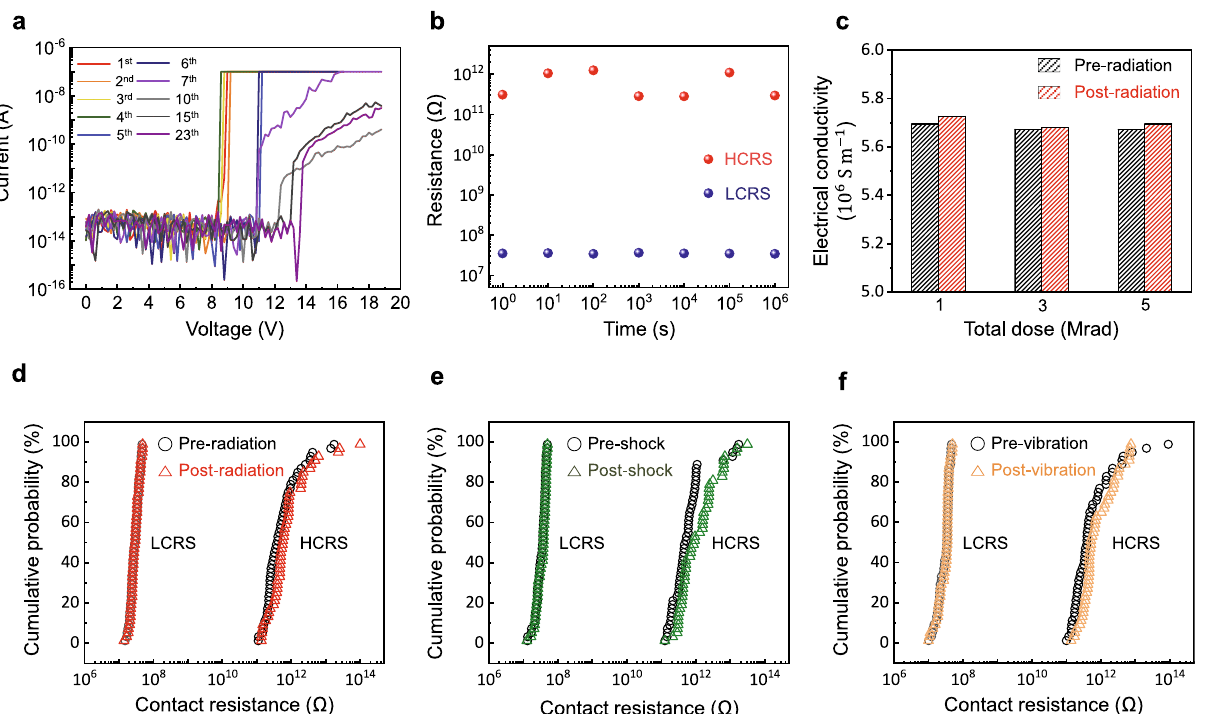
Fig. 4 | Basic NEM-NVM performance and robustness of mechanical bits. a Current – voltage (I – V) characteristics during cyclic measurements. b Stable retentionbehaviorforatimeof10 6 satroomtemperature. c Electricalconductivity of nano-patterned tungsten before and after exposure to various total radiation doses (1, 3, and 5Mrad). d Gamma-radiation stability (1Mrad) of the mechanical bits. The black circle represents LCRS and HCRS before exposure to gamma-